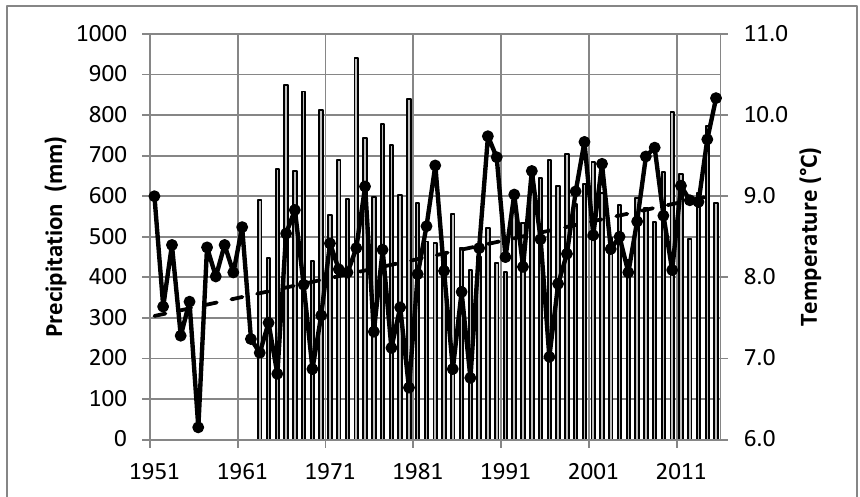
Figure 4. Mean annual air temperature at the Puławy station in the period 1951–2015 (increasing trend) and total annual precipitation in the watershed of Zagożdżonka River in the period 1963– 2015 (no trend).